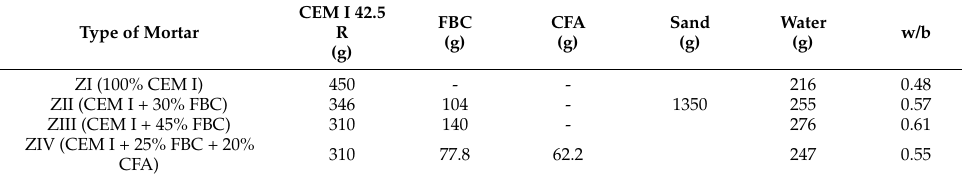
Table 5. Particle-size distribution of cement–fly-ash binders.